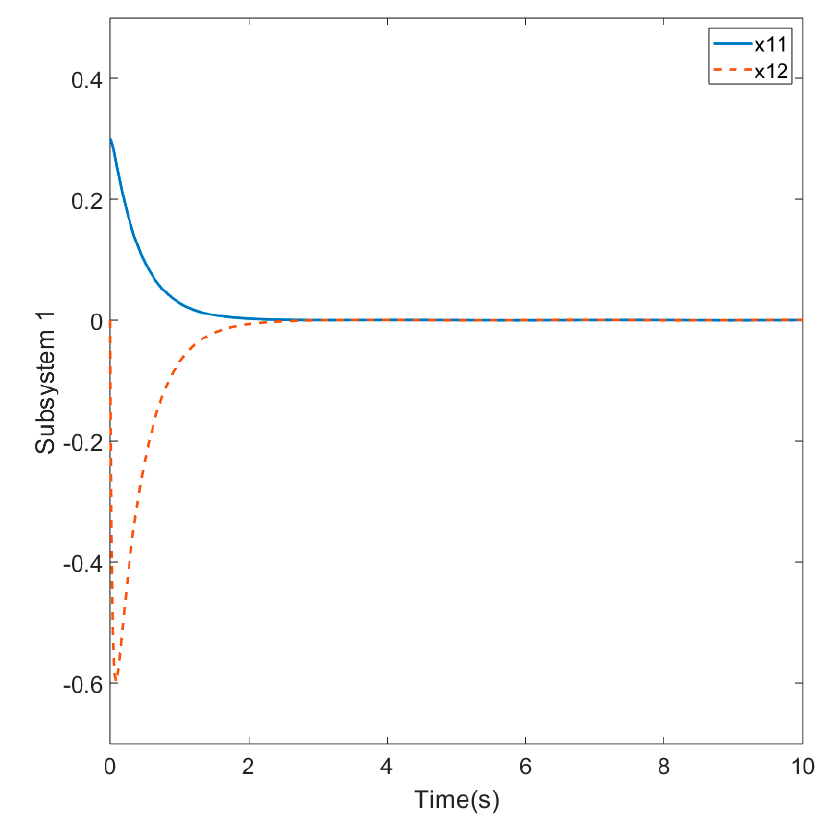
x for Example 2. Figure 9. Responses of x 1 for Example 1